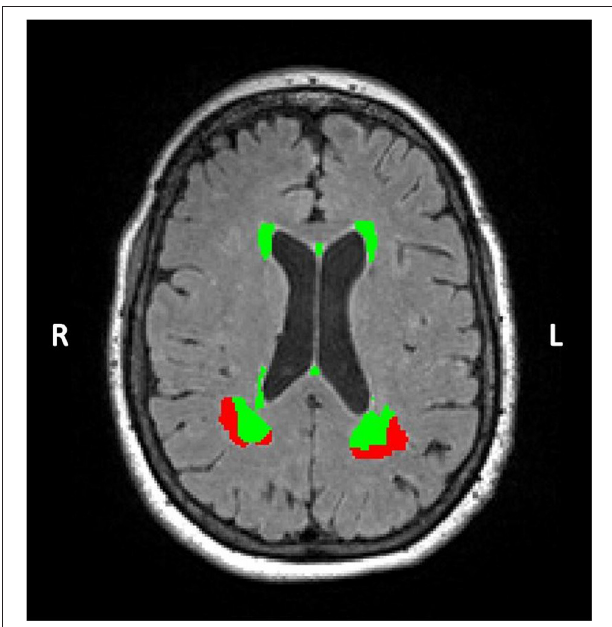
FIGURE 2 | A Sample Segmented WMH Mask. In this axial FLAIR slice, WMHs in a representative participant are color-coded according to being in either PV (green) or deep (red) regions. WMH volume was extracted from each region separately for every